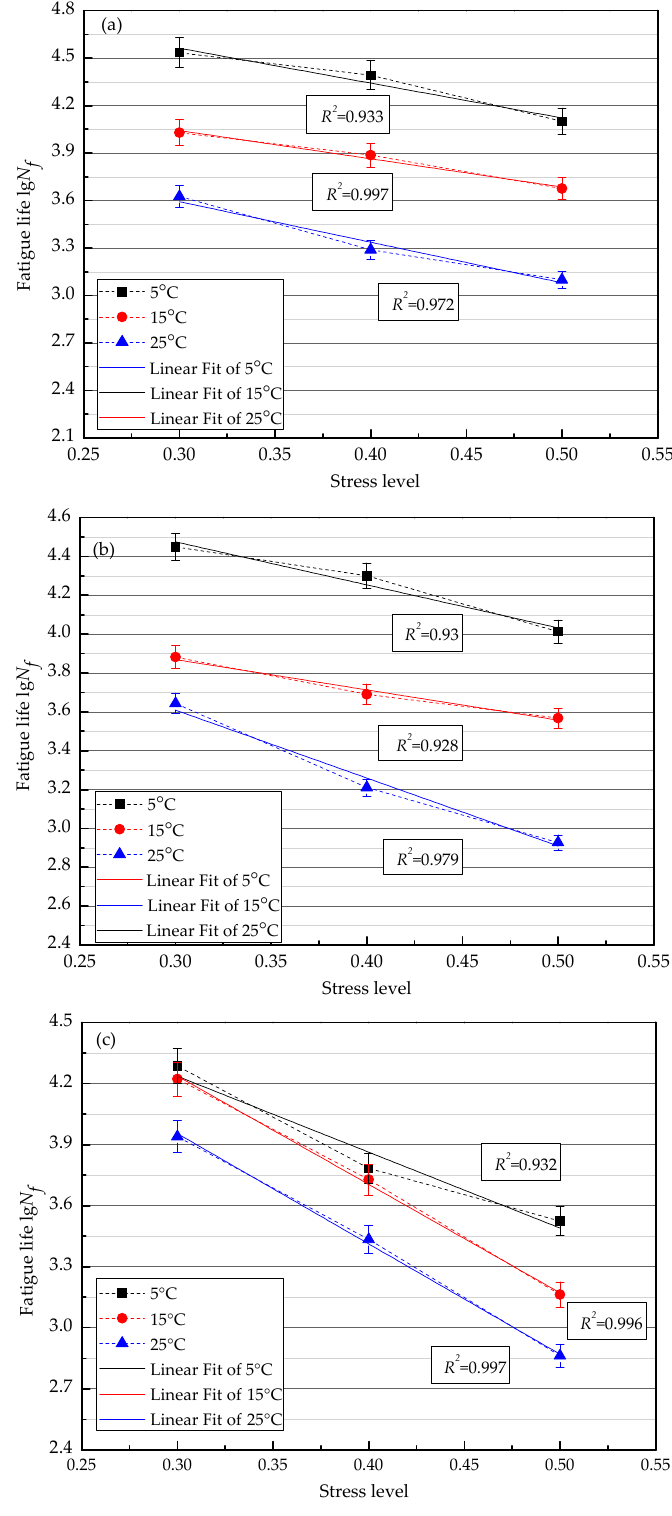
Figure 9. Single logarithmic fatigue curve equation for different thicknesses structure combinations under different stress ratio level: ( a ) C1; ( b ) C2; and ( c ) C3.